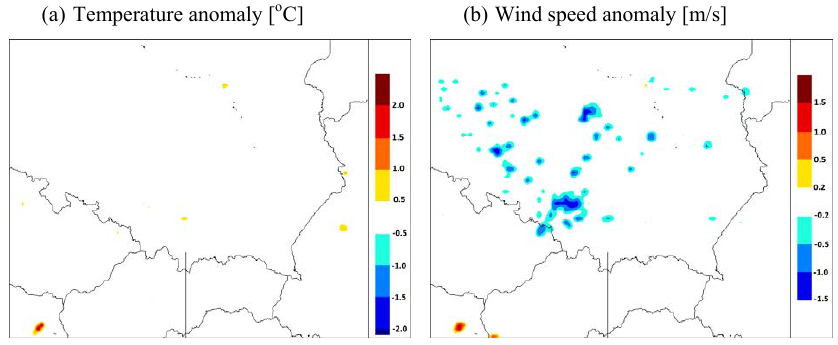
Figure 3. Temperature (a) and wind speed (b) anomaly calculated as the difference between urban and non-urban scenarios – 6 November 2010, 15:00UTC.